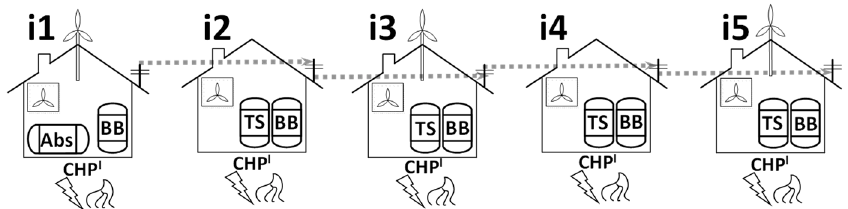
Figure 4. Design of the Baseline scenario network. Table 6. Integrated DER technologies installations for the Baseline